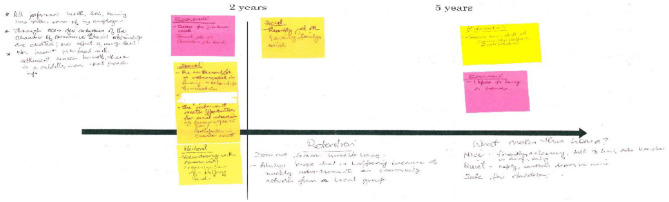
C-IMM2's timeline.